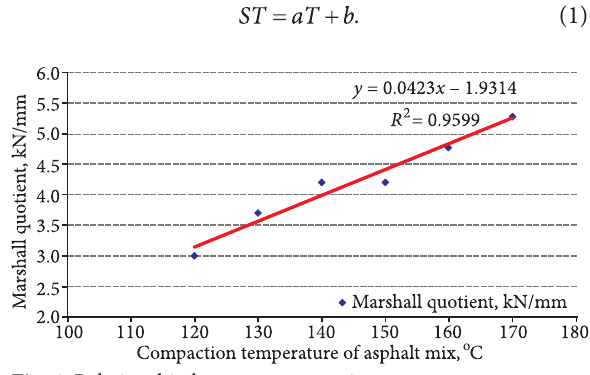
Fig. 4. Relationship between compaction temperature and Marshall